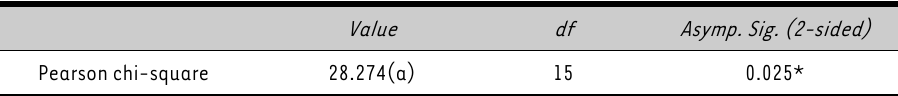
Chi square test results on tender application Value df Asymp. Sig. (2-sided) Pearson chi-square 28.274(a)